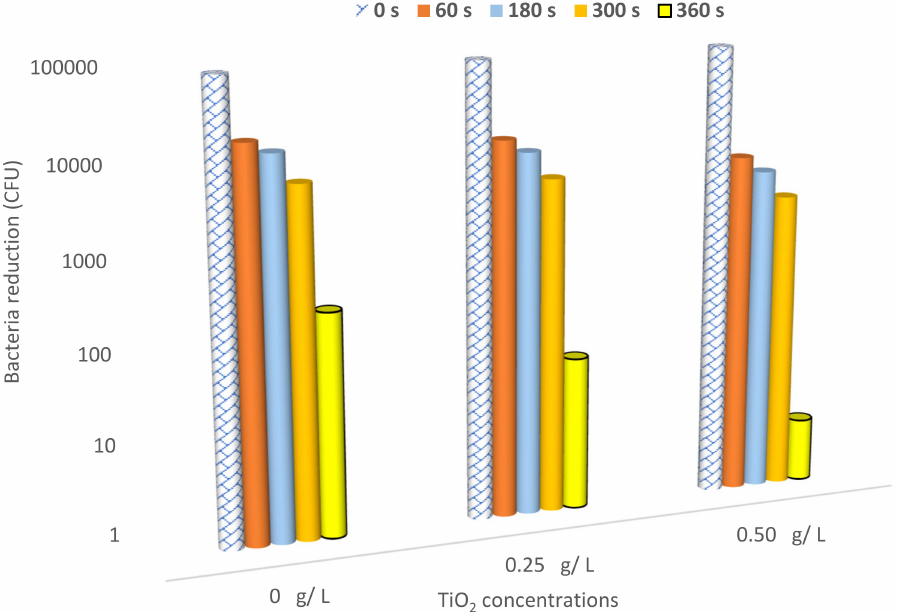
Figure 7. Bacterial reduction (logarithmic scale) in the cell-forming unit per milliliter (CFU/mL) as a function of TiO 2 concentration: 0, 0.25, and 0.50